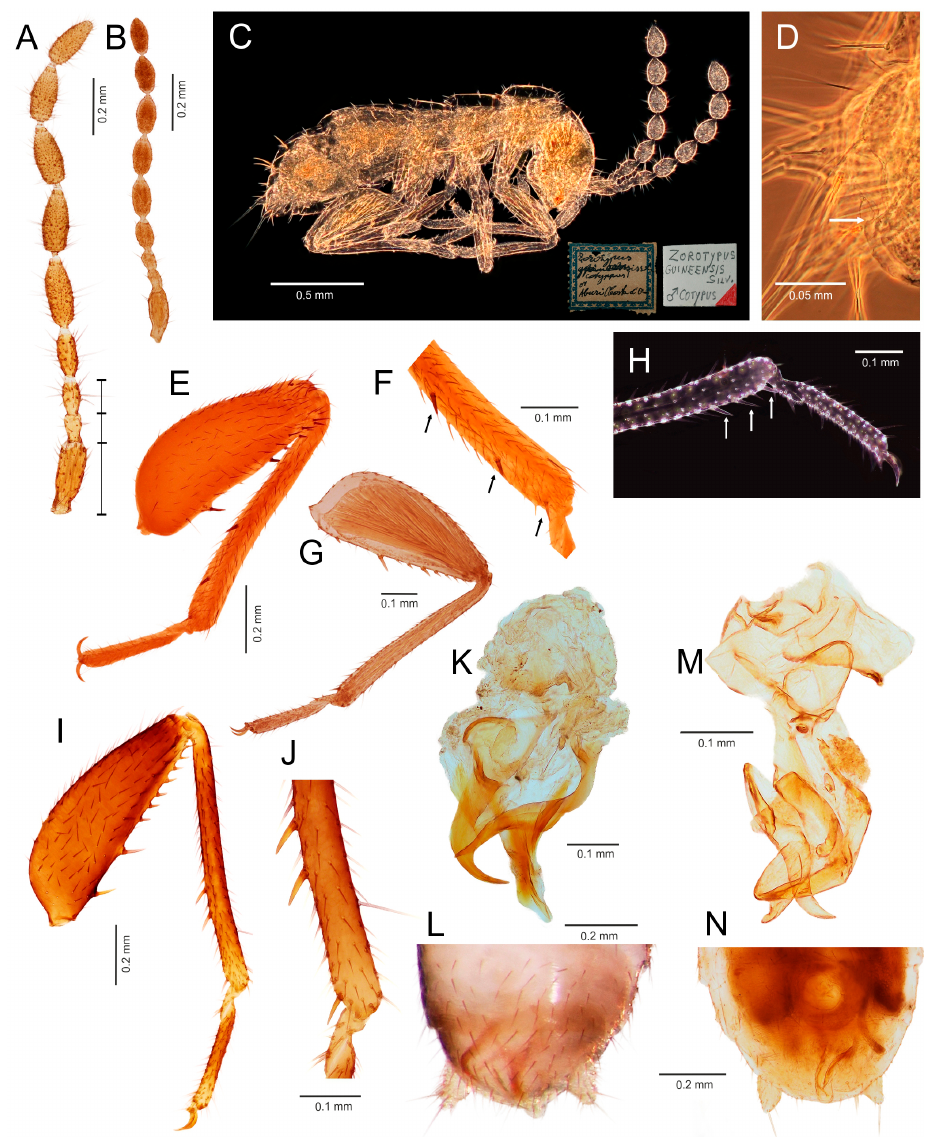
Figure 2. Morphological characters of Zorotypidae: Zorotypinae. ( A ) left antenna of Zorotypus delamarei with lengths of the three basal antennomeres indicated, male, Madagascar; ( B ) right antenna of Usazoros hubbardi , male, USA; ( C ) slide-mounted type of Z. guineensis photographed with phase contrast, with original labels, male, Ghana; ( D ) lateral view of the apex of abdomen of type of Z. guineensis , photographed with phase contrast and focused on abdominal tergites, arrow indicate projection of abdominal tergite (probably TXI—see the text), male, Ghana; ( E ) right hind leg of Z. guineensis , Ghana, non-type, unknown sex; ( F ) detail of right metatibia of Z. guineensis , Ghana, non-type; arrows indicate position of metatibial spurs; ( G ) right hind leg of U. hubbardi , male, USA; ( H ) detail of right metatibia of U. hubbardi male, USA, photographed with phase contrast and focused only on layer with spurs; arrows indicate position of tibial spurs; ( I ) right hind leg of Z. delamarei , male, Madagascar; ( J ) detail of right metatibia of Z. delamarei , male, Madagascar; ( K ) genital of Z. delamarei , ventral view, male, Madagascar; ( L ) ventral view of the apex of abdomen of Z. delamarei , male, Madagascar; ( M ) genitalia of U. hubbardi , male, USA; and ( N ) ventral view of the apex of abdomen of U. hubbardi , male,